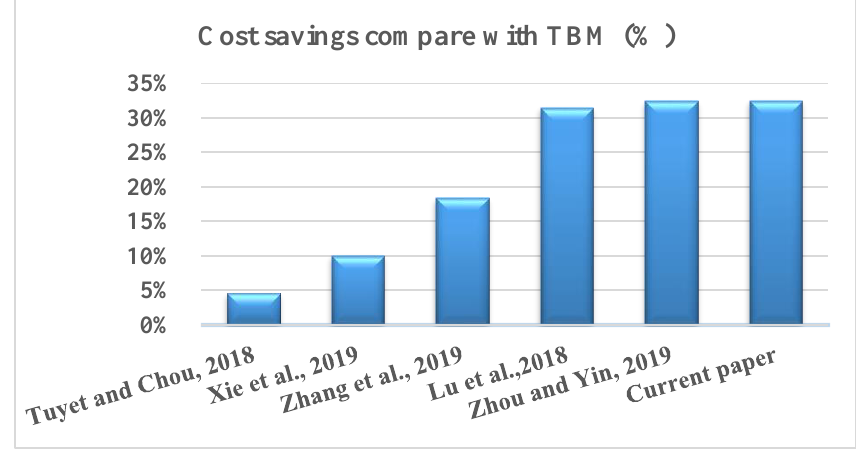
Figure 8. Cost saving compared with time-based maintenance (TBM).